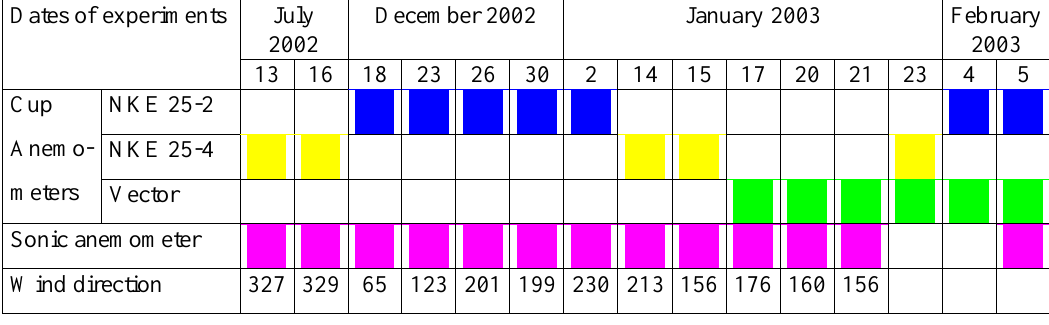
Table 1: Different periods of the experiment with the relating mean wind directions and used sensors. Table 2. Data pertaining to the upper frequency limit, f max , the relating amplitude attenuation and the ratio between the previous frequency and the cup anemometer cutoff frequency, f max /f co . Cup anemometer 25-2, date of 30 December 2002.